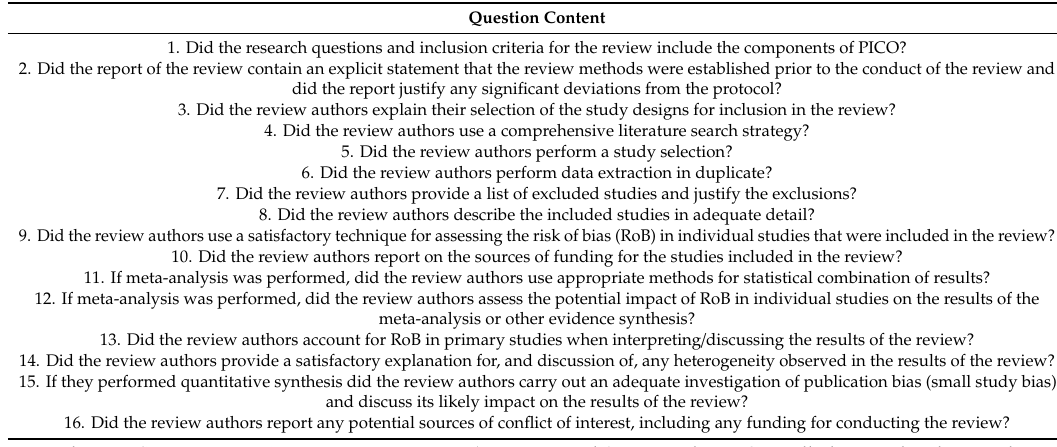
Table 2. Question content of the AMSTAR